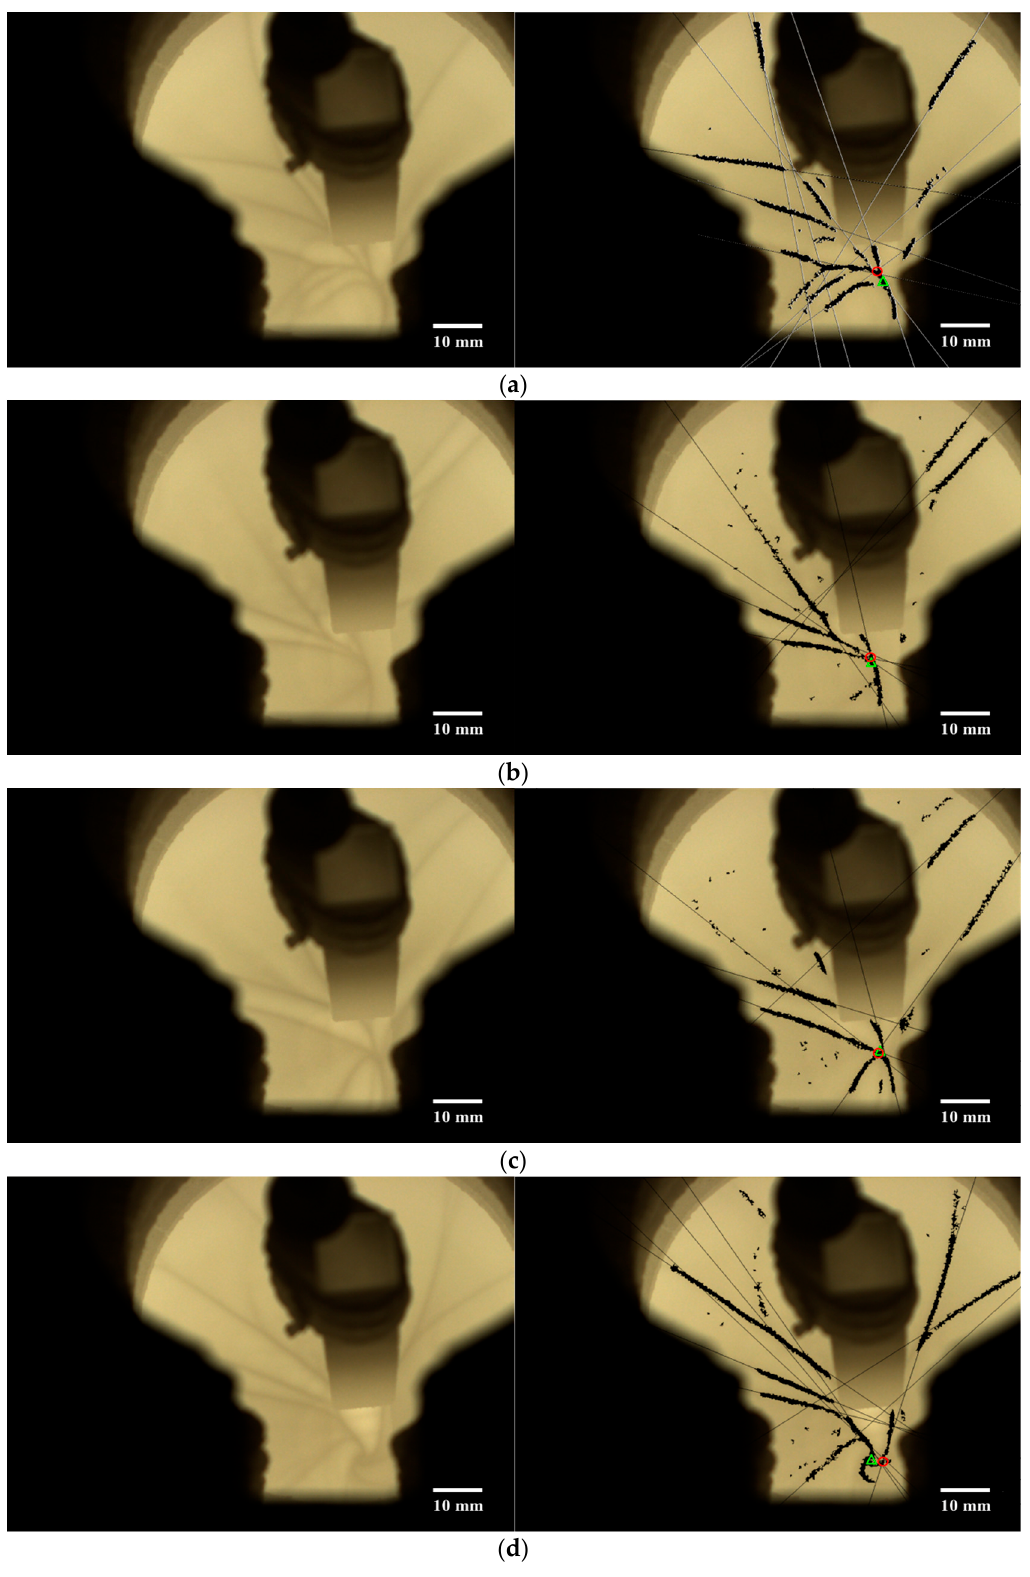
Figure 10. Image processing results of the melt surface. ( Red : island position, Green : position of image processing result).